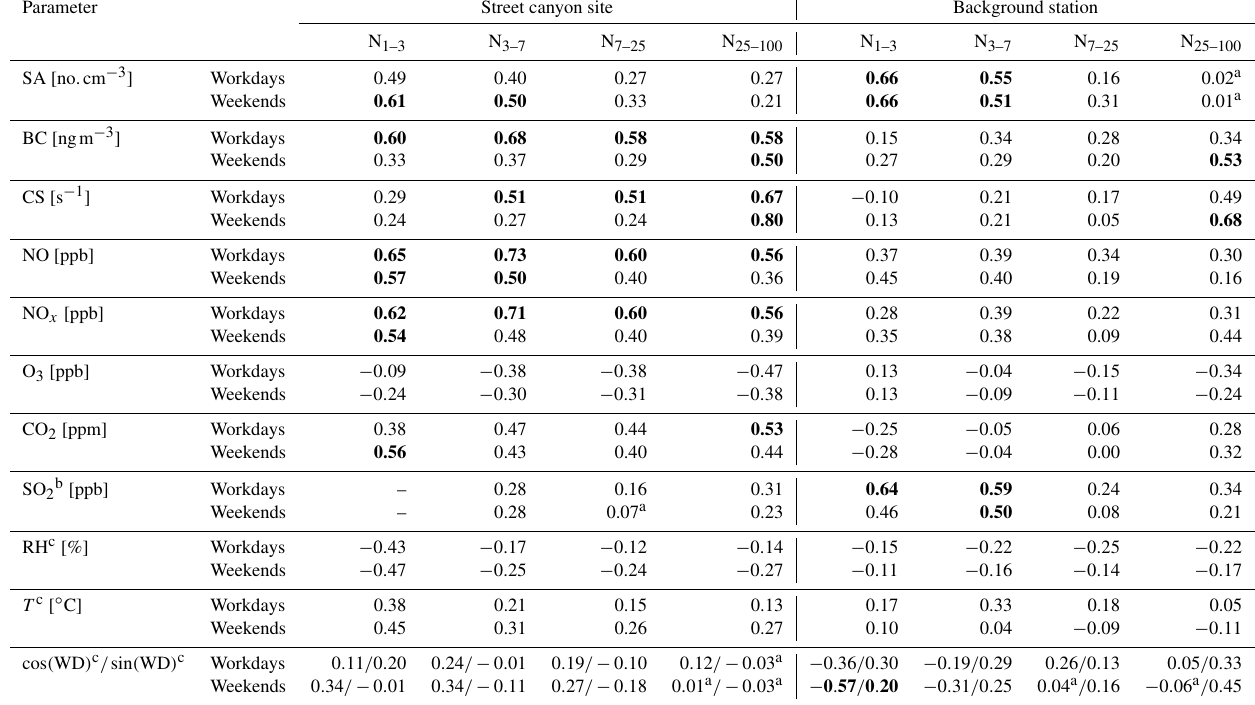
Table 3. Correlation between logarithmic values of N 1–3 , N 3–7 , N 7–25 , and N 25–100 and logarithmic values of other variables during week- ends and workdays at the street canyon and the background station. Correlations with a Pearson’s correlation coefficient higher than 0.5 are marked in bold. The sample size for this analysis is presented in Table S1 in the Supplement.